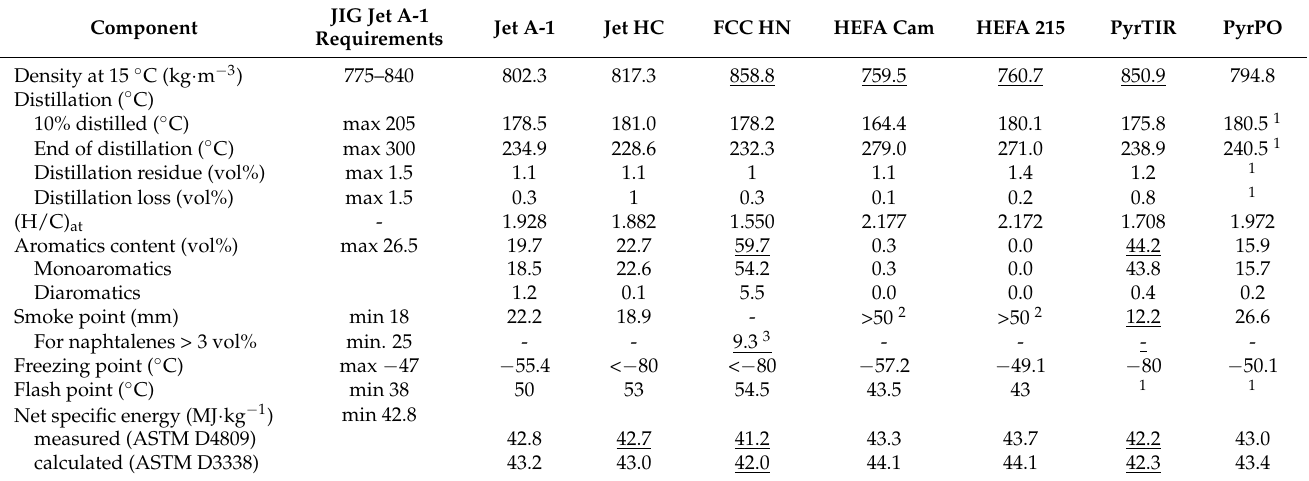
Table 1. Key properties of the samples